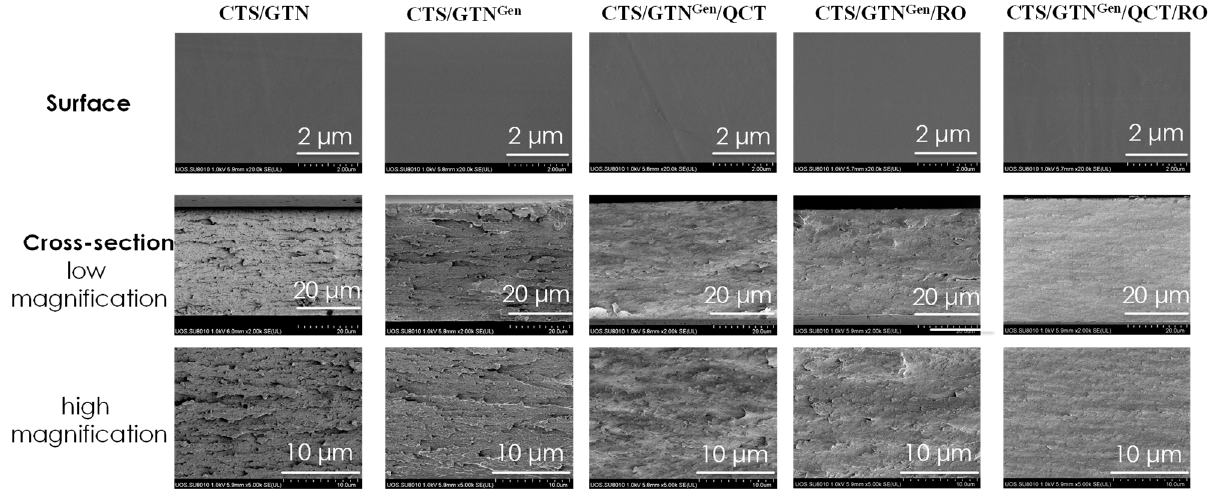
Figure 2. Morphology (surface and cross-section) of the chitosan/gelatin-based